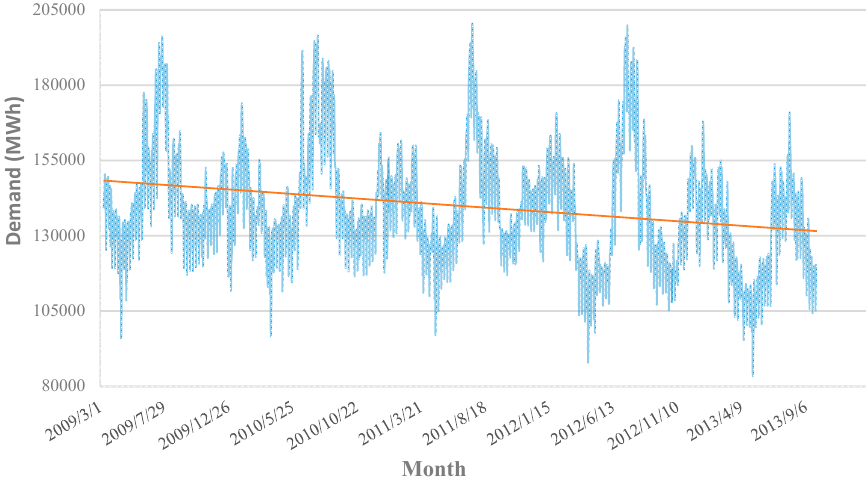
Figure 4. Daily data of electricity demand in Greece during the period March 2009 to November 2013 (data as acquired from [48]).